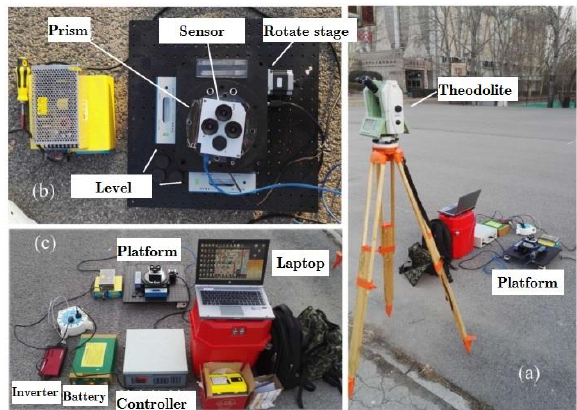
. (9) Figure 6. (a) General arrangement in the experiment field (b) part of the field (c) arrangement of instruments on the optical platform